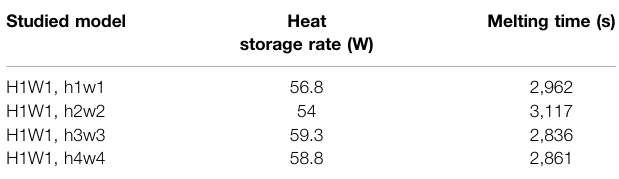
TABLE 5 | The total heat storage rate and melting time for various dimensions of the T-shaped fi ns body [with a similar size to the fi n ’ s head